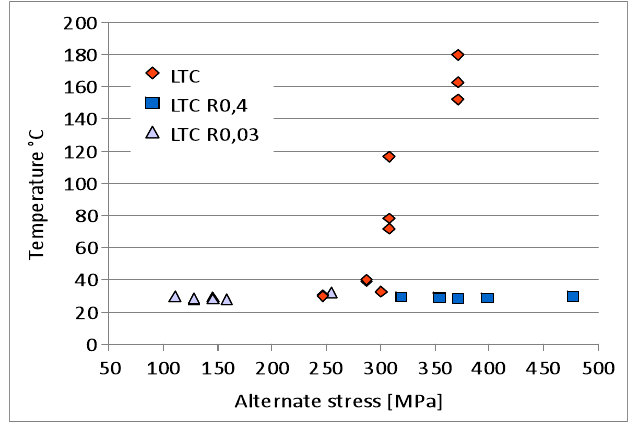
Fig. 6: Temperature rise Fig. 7b: Close-up of the fatigue crack origin in specimens with a blunt notch Fig. 8b: Close-up of the fatigue crack origin in specimens with a sharp notch